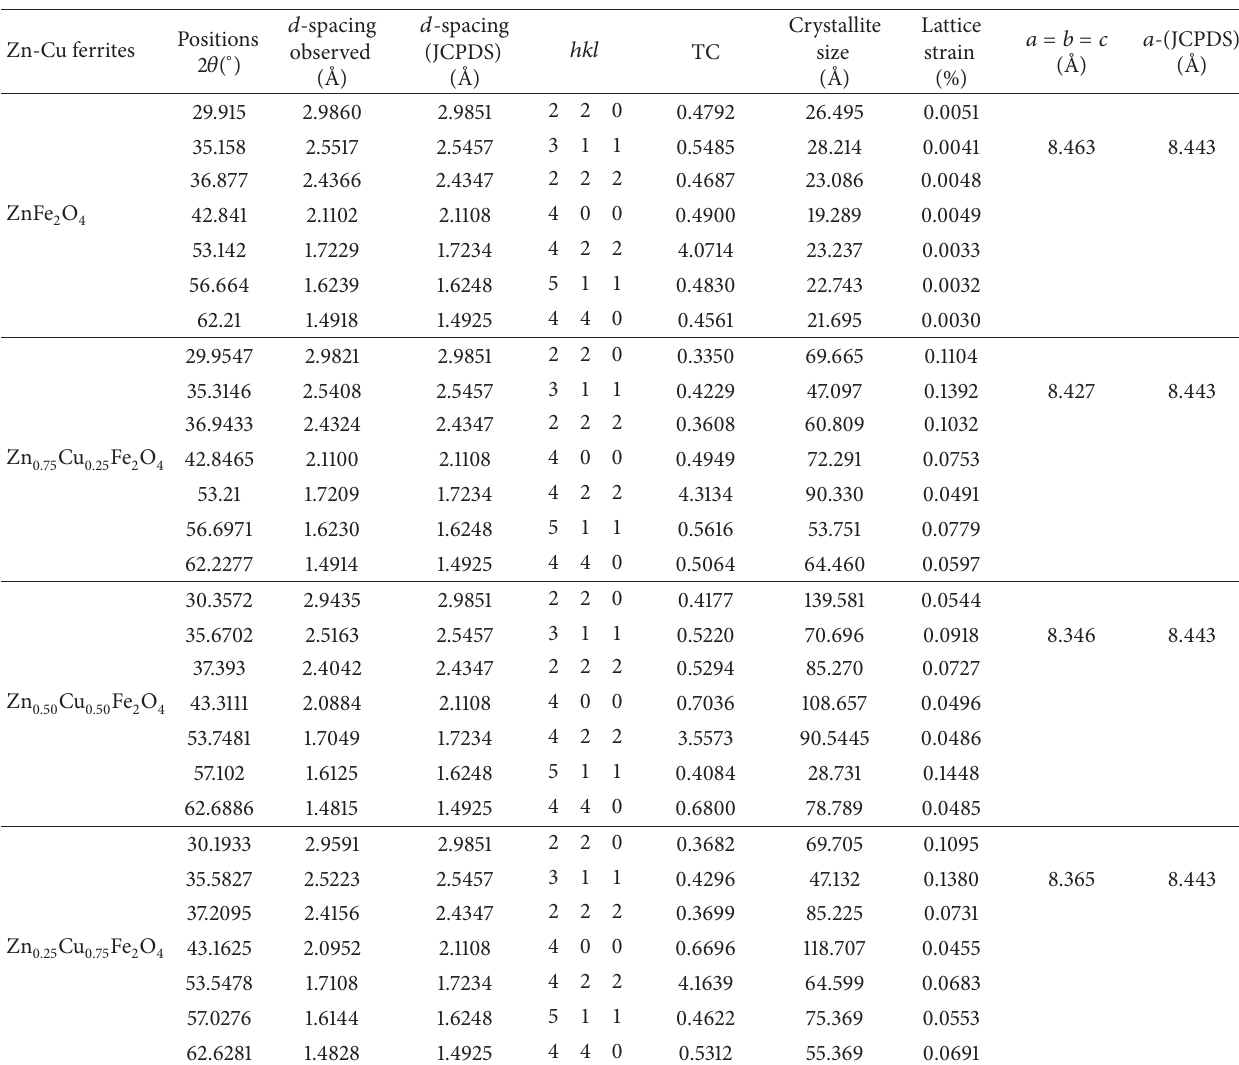
Table 1: Structural properties of the Zn-Cu